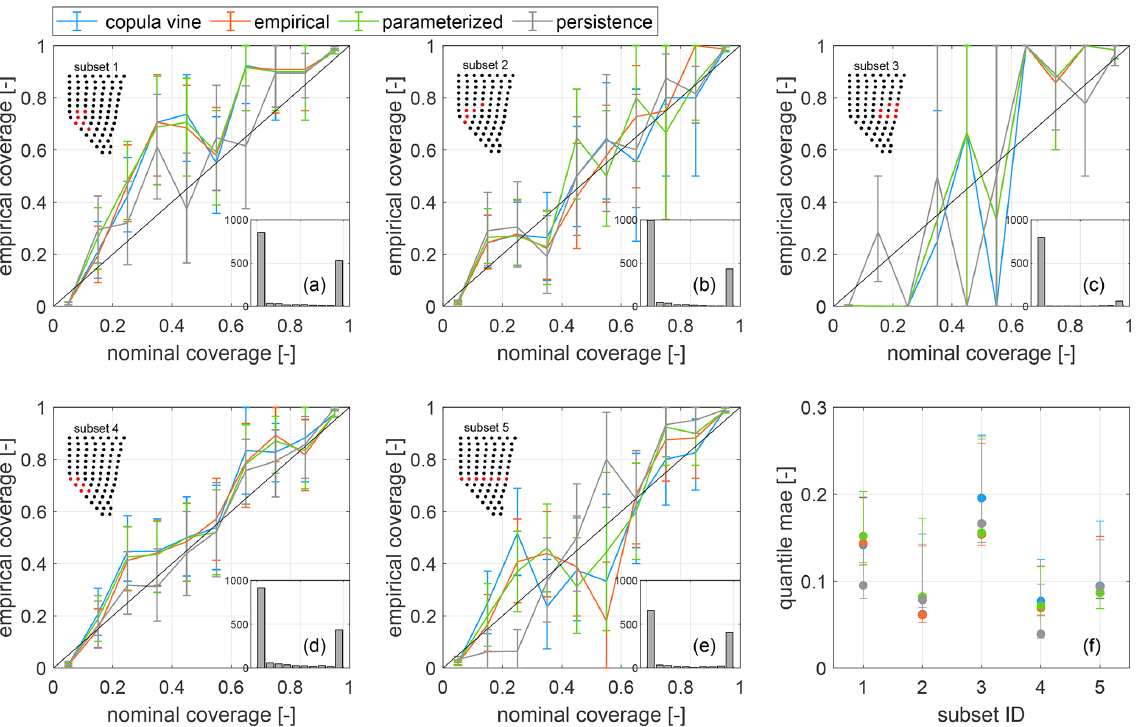
Figure 11. (a–e) Reliability diagrams for the different turbine subsets (1–5) and copula approaches summarized in Table 1 and persistence. The turbine subsets are marked in red in the small wind farm layouts. Histograms show the number of valid forecasts per quantile step for the empirical copula approach. The diagonal black line indicates perfect reliability. In (f) the corresponding quantile maes are shown. For all subfigures 95% confidence intervals are visualized as error